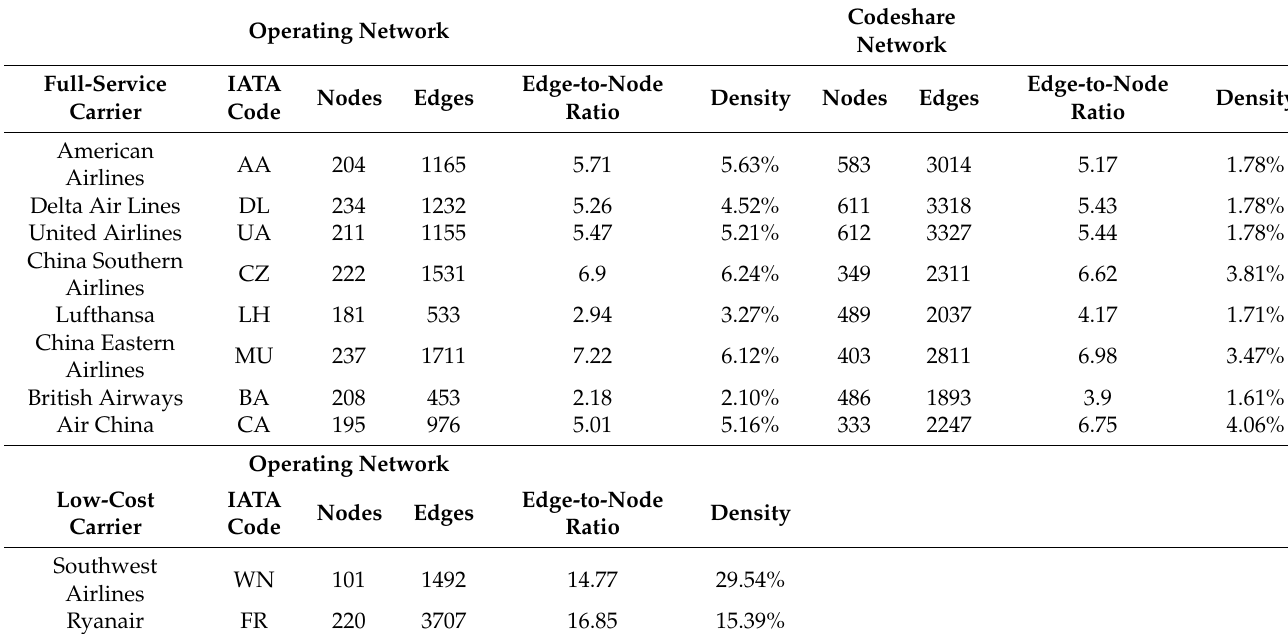
Table 2. Statistics results for selected 10 airlines (excluded